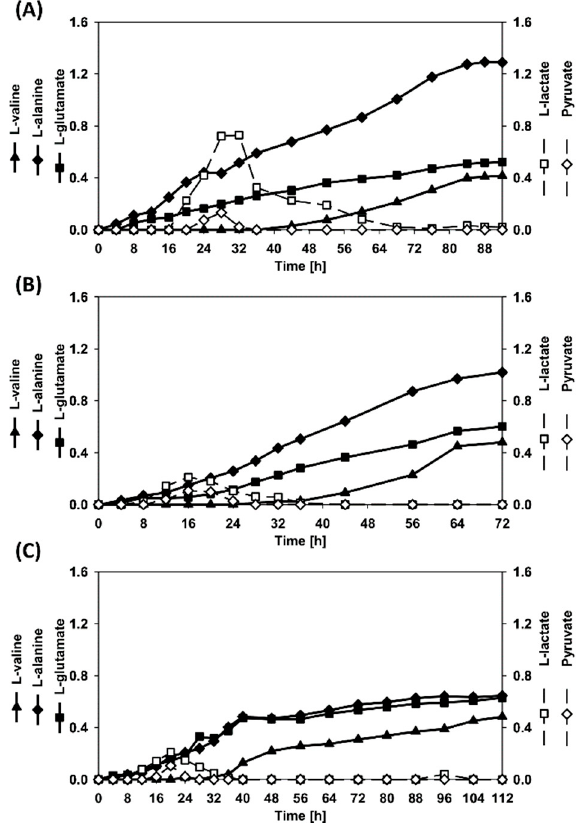
Figure 6. Accumulation of by-products during the batch co-cultivation processes. ( A ) RiboXyl inoculated together with RiboMan, ( B ) RiboXyl inoculated during the exponential phase of RiboMan, and ( C ) RiboXyl inoculated during the stationary phase of RiboMan. Data is depicted as follows: L -glutamate (filled squares), L -alanine (filled diamonds), L -alanine (filled triangles), L -lactate (empty squares), and pyruvate (empty circles).